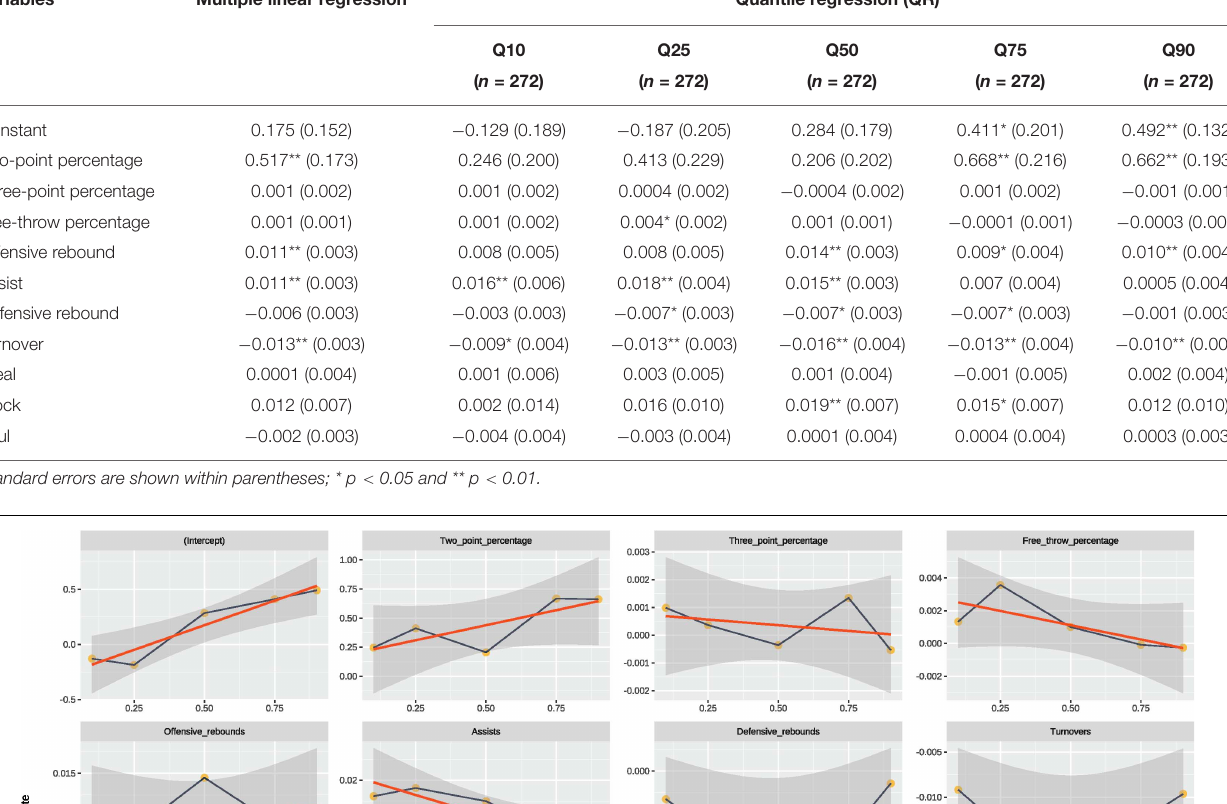
TABLE 2 | Parameter estimates from multiple linear regression (MLR) and quantile regression (QR) on the difference quantiles of final score. Variables